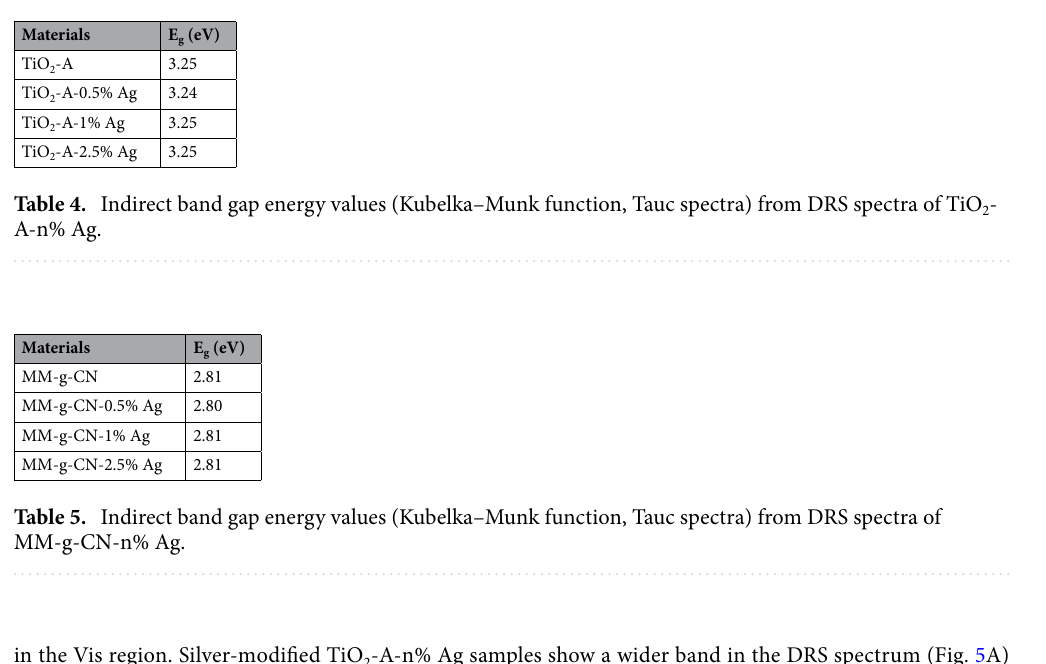
Figure 6. Diffuse reflectance UV–Vis spectra ( A ) and Tauc spectra ( B ) at wavelengths from 220 to 800 nm of pure MM-g-CN and MM-g-CN-n% Ag.